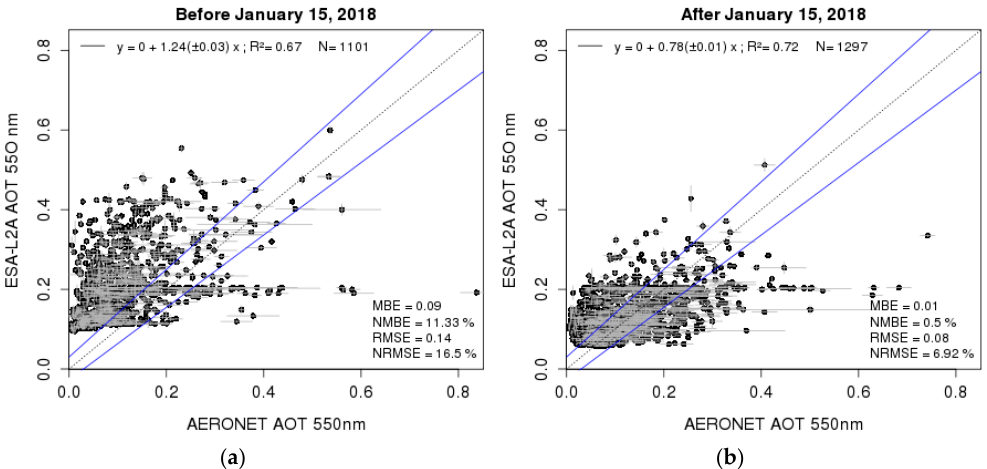
Figure 3. Scatter plots of AOT from ESA-L2A retrievals versus coincident AERONET Level 2.0 data for ( a ) before 15 January, 2018 and ( b ) after 15 January, 2018. The dashed grey line indicates the x = y line and the solid blue lines show the accuracy requirement limits (a) | ∆ AOT 550 | ≤ 0.1 × AOT 550 ref + 0.03, and (b) | ∆ IWV | ≤ 0.1 × IWV ref + 0.2